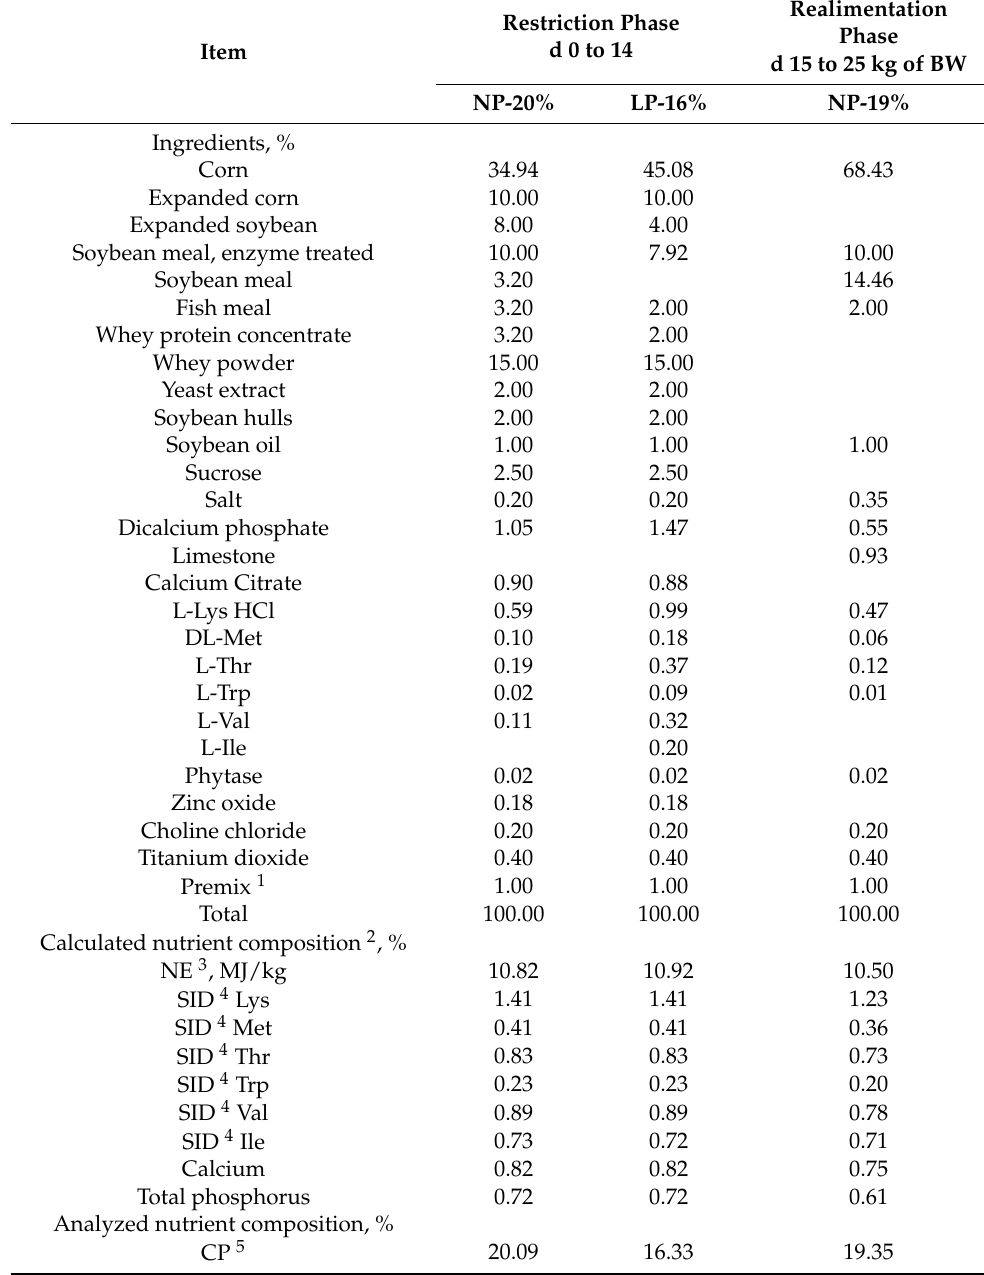
Table 1. Ingredient and nutrient composition of experimental diets in piglets (% as-fed basis). Restriction Item